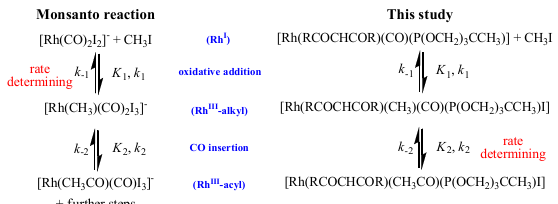
Table 1. The second order rate constant for the